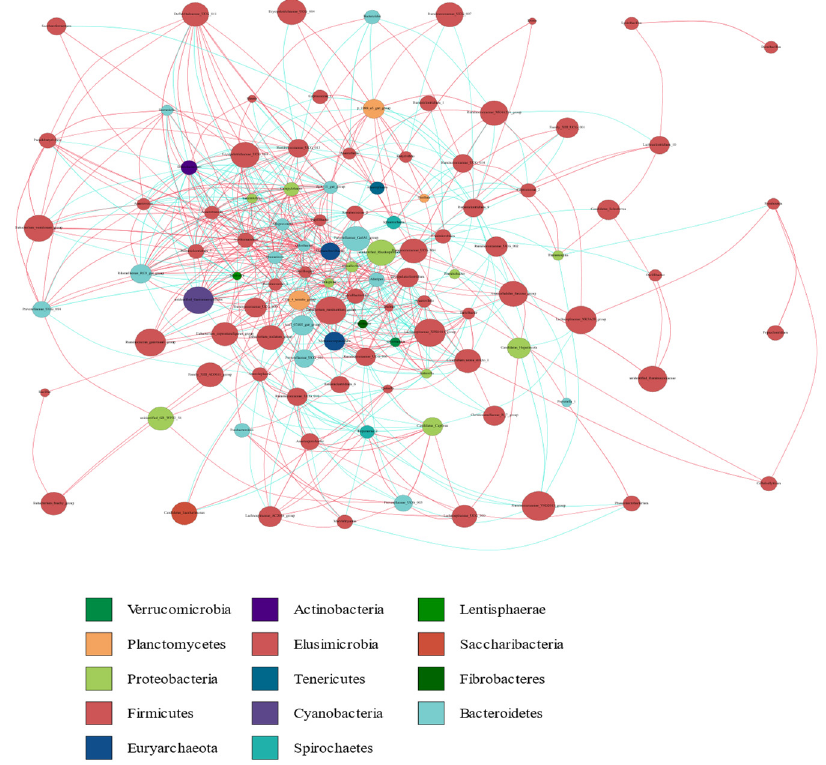
Figure 8. Microbial co-occurrence networks analysis. Each node represents a genus. Each edge indicates the sign of the association (green = positive (co-occurrences), red = negative (co-exclusions)). The thickness of the nodes represents the level of association between taxa.